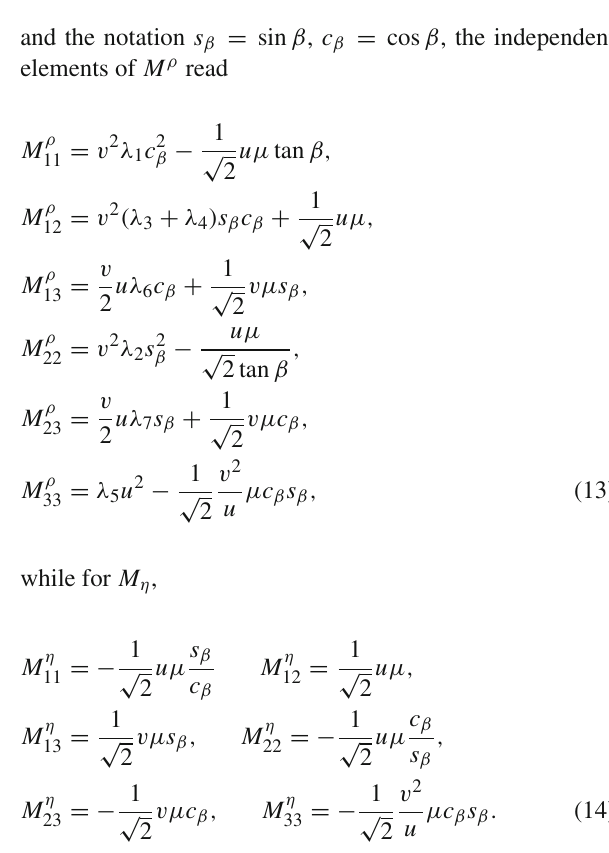
Table 1 SM and U(1) (cid:2) hypercharges ψ ∼ ( Y , Y (cid:2) ) of the fermions and scalars in the UN2HDM. Generation indices in SM fermions are omitted, as well as colour indices for quarks